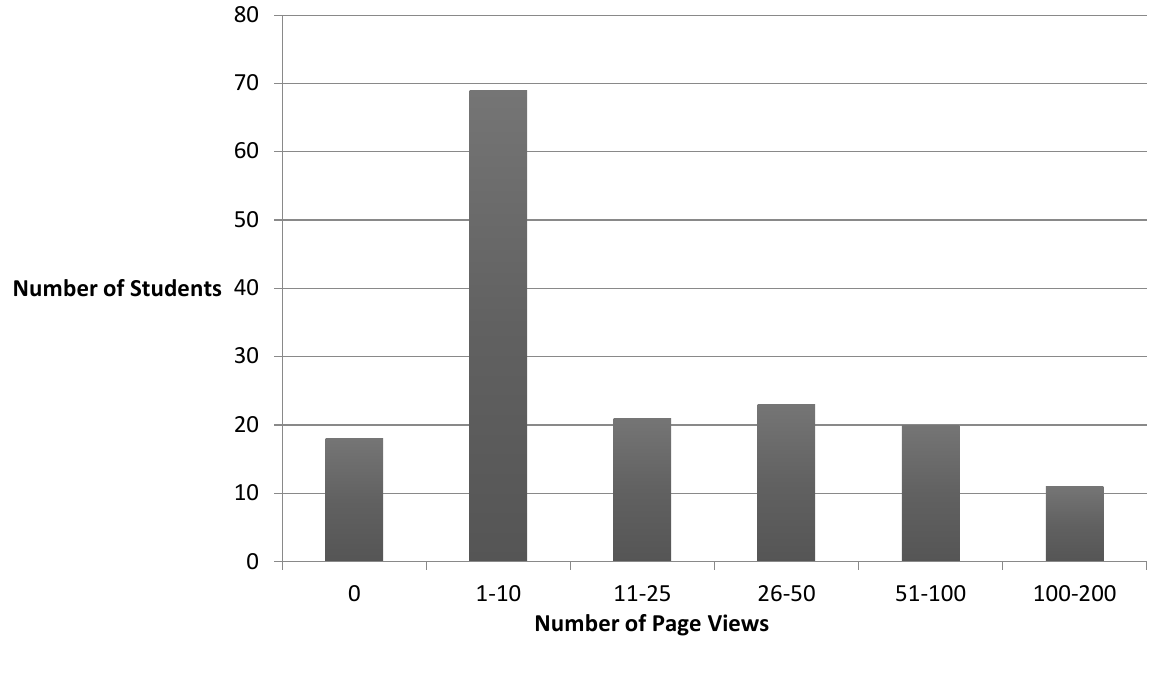
Figure 2. Number of page views per student. Note: these data were collected two years after the project ended at which time there were only 169 of the 198 program alumni who remained members of the